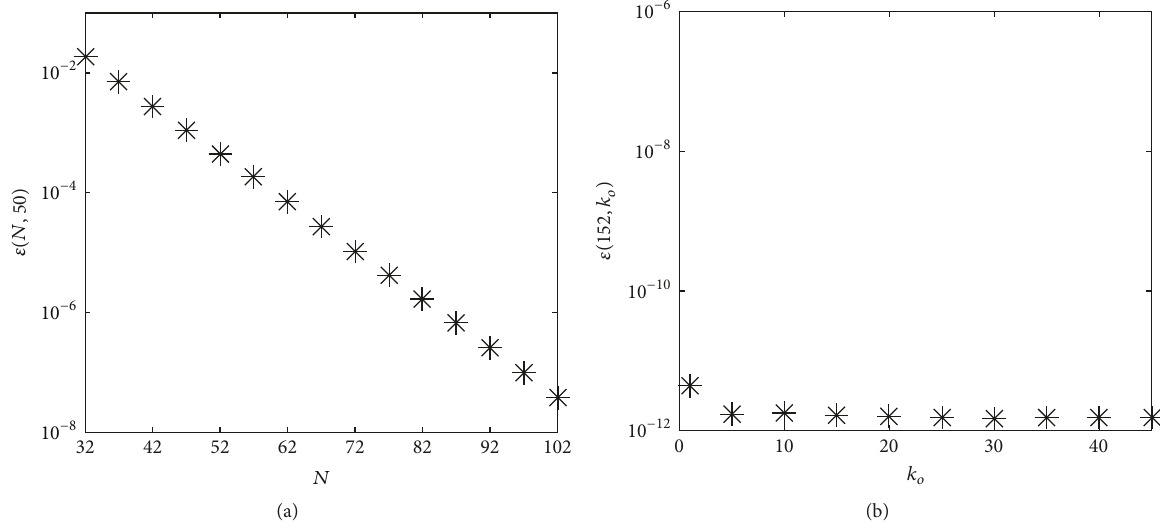
Figure 17: Relative error of the free system response estimated future value using different (a) 𝑁 and (b) 𝑘 𝑜 for the R¨ossler system.